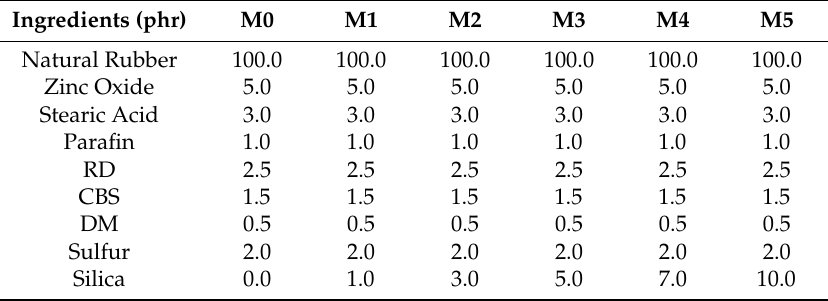
Table 1. The composition of silica / natural rubber